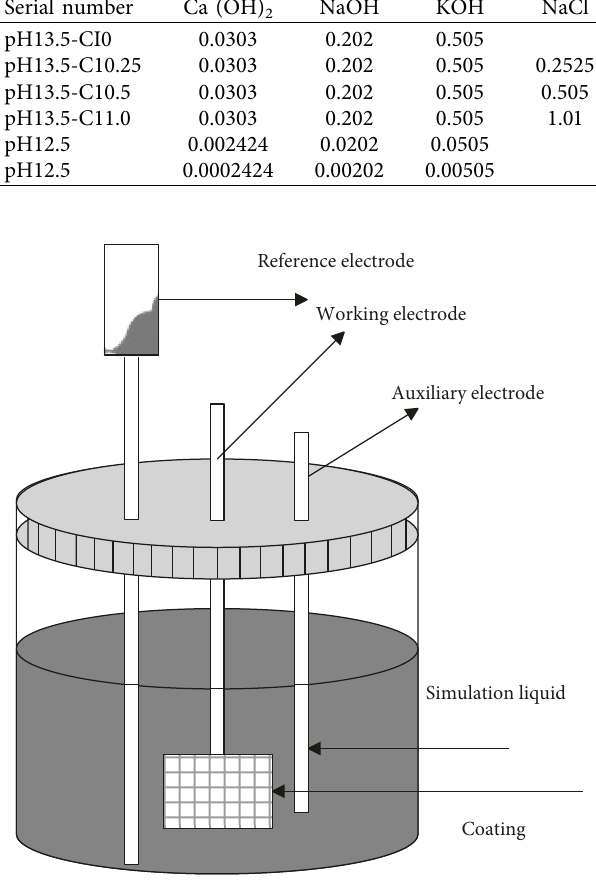
Figure 5: Electrochemical test